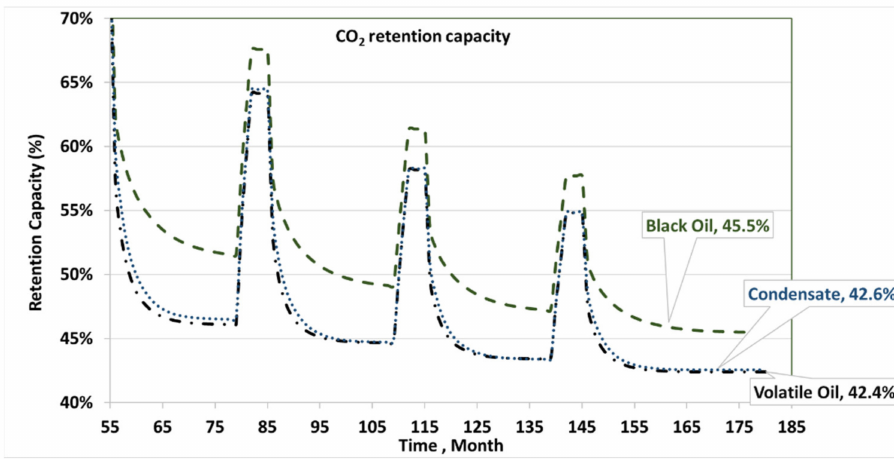
Figure 9. The retention capacity for different fluid